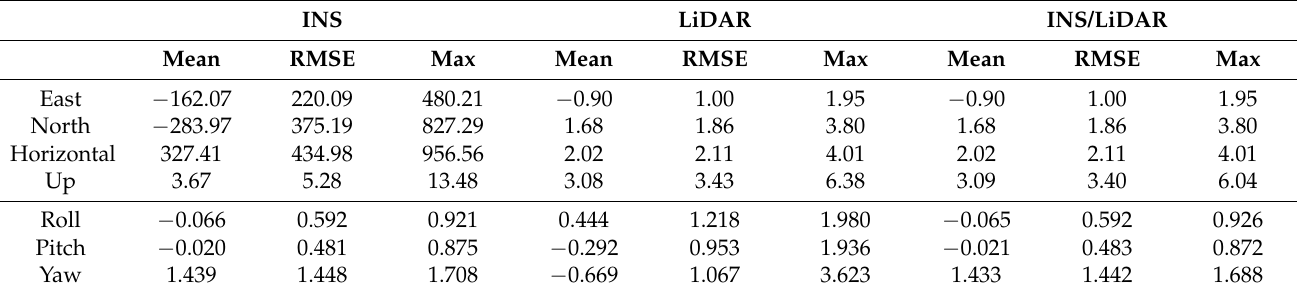
Table A3. D-20—position (m) and attitude (deg) error statistics.